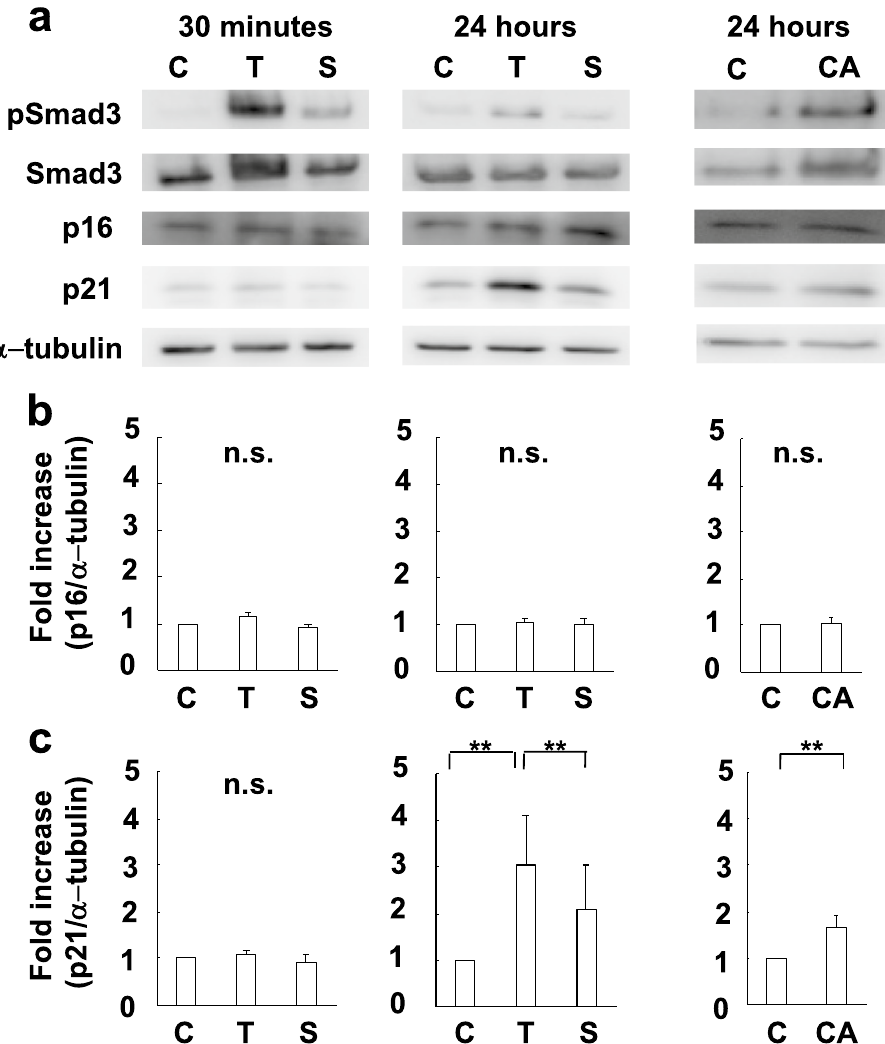
by the stimulation of the TGF-β1-Smad3 pathway. ( b , c ) Activation of the TGF-β1-Smad3 pathway can increase the expression of p21 in 24 h (late phase), but not that of p16 in endothelial cells (N = 3). C: control. T: TGF-β1. S: SB431542. CA: constitutive active Smad3. pSmad3: phosphorylated Smad3. n.s.: not significant. ** P < 0.05